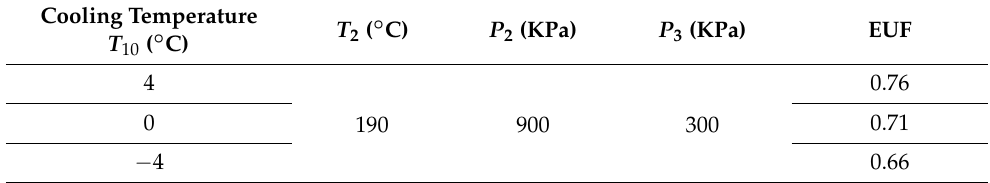
Table 10. Effect of cooling temperature on EUF for a selected operating